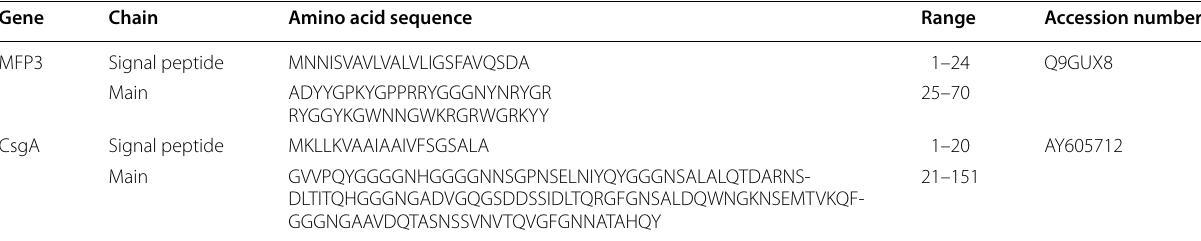
The synthesis of both genes was arranged without considering the signal peptide chain which includes 24 and 20 amino acids for MFP3 and CsgA genes, respectively